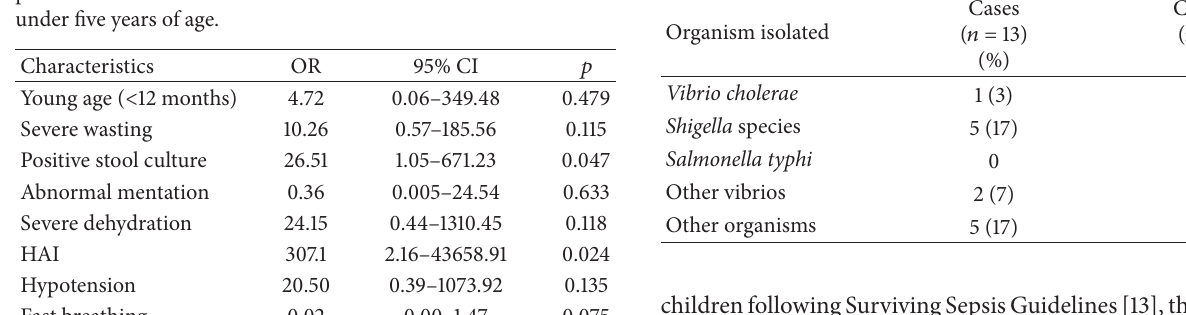
Table 2: Results of logistic regression analysis to explore the inde- pendent association of Klebsiella bacteremia in diarrheal children under five years of age.